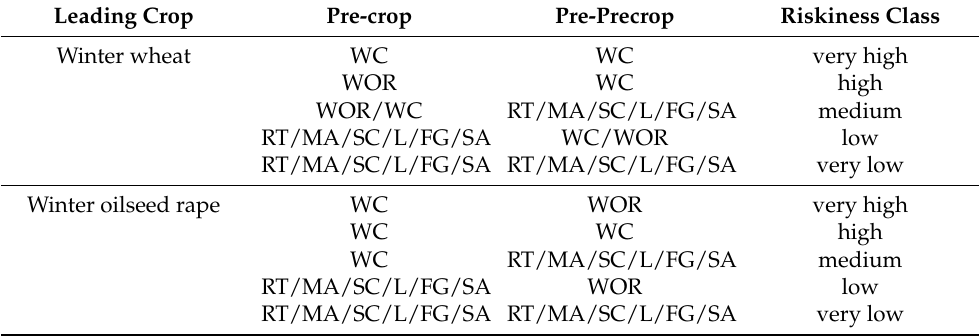
Table 1. Riskiness classes for weeds in a certain crop, according to its combination with the two preceding crops (pre-crop and pre-precrop). MA (maize), WC (winter cereals), SC (spring cereals), RT (roots and tubers), WOR (winter oilseed rape), L (legumes), FG (field grass) and SA (set-aside). Leading Crop Pre-crop Pre-Precrop Riskiness Class Winter wheat WC WC very high WOR WC